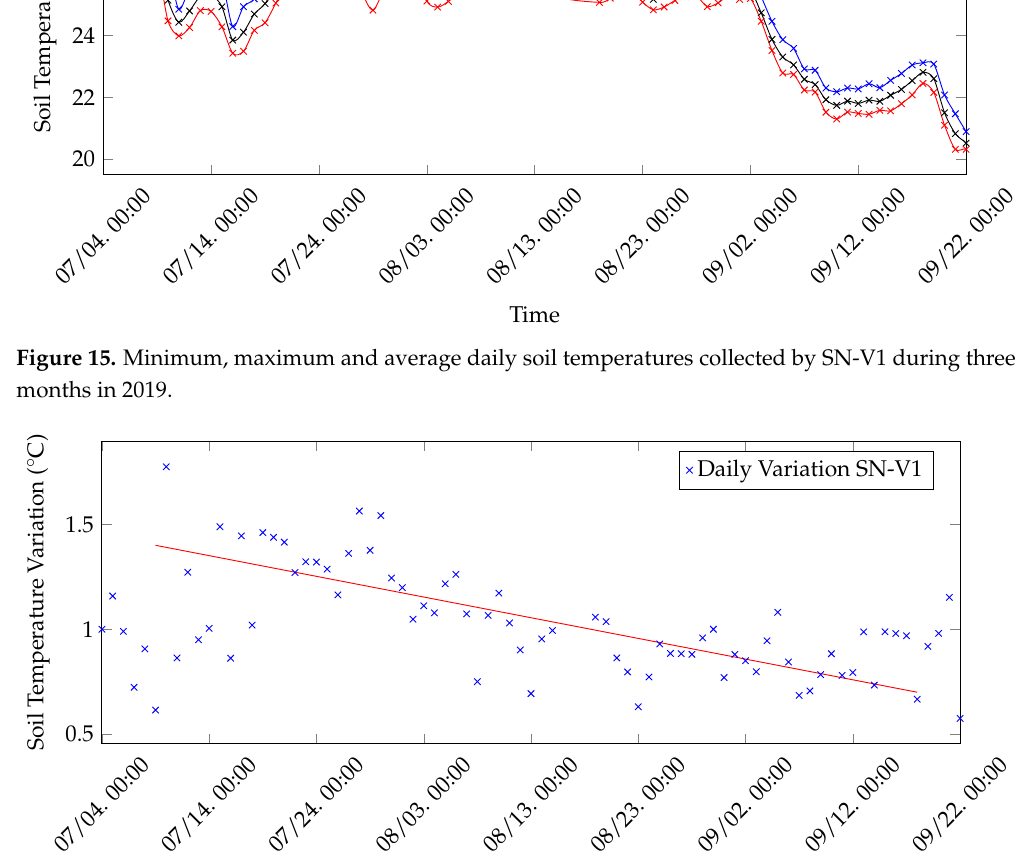
Figure 16. Daily soil temperature variation (namely, differences between daily maximum and minimum temperature) of SN-V1 measurements, during three months of test in 2019.